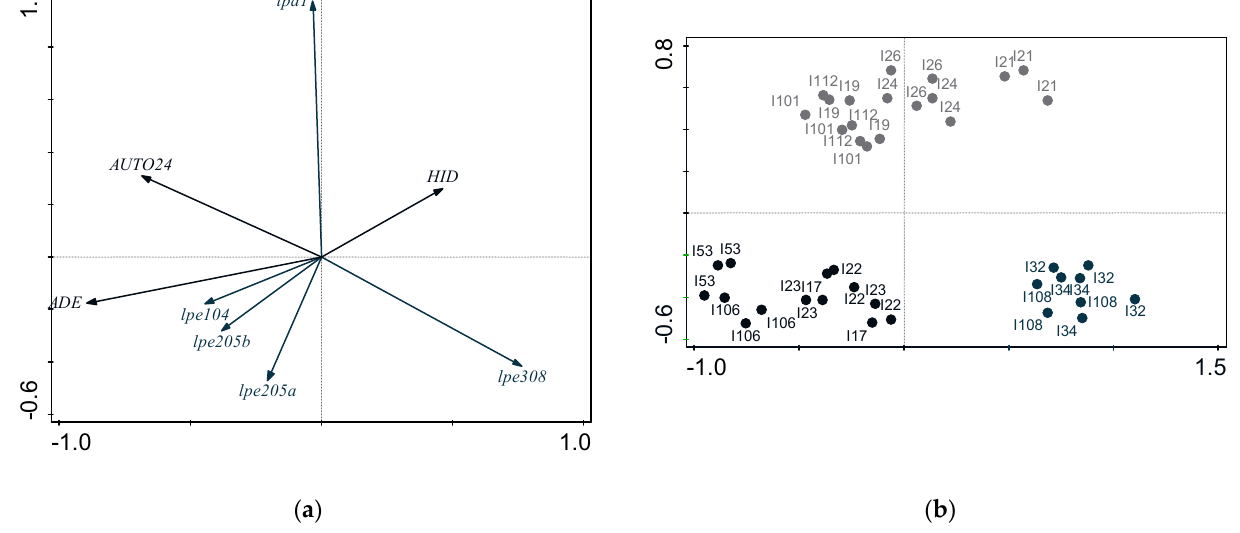
Figure 2. ( a ) Plot of loadings formed by first two principal components from Principal Component Analysis, pertaining to probiotic characteristics associated with gastrointestinal tract and RAPD profile; and ( b ) plot of scores encompassing strains isolated from Cobrançosa table olives.